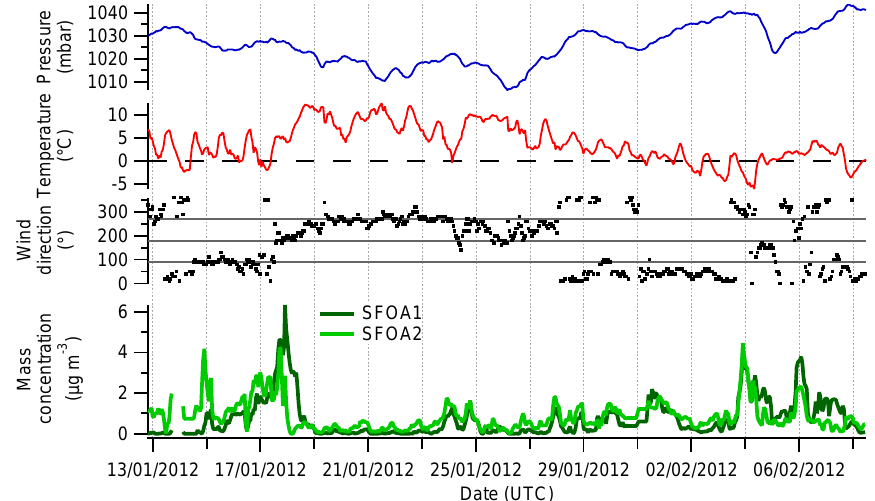
Figure 2. Time series of SFOA1 and SFOA2 concentration and meteorological data from the Heathrow airport meteorological station. The horizontal grid lines in the wind direction sub-plot, from top to bottom, represent westerly, southerly and easterly wind directions, respectively.